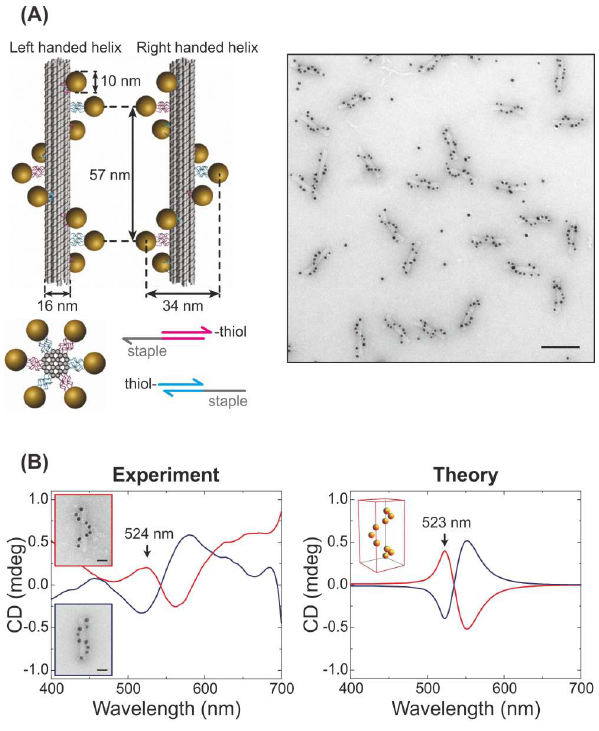
Figure 8: (A) Schematic blueprint of self-assembled gold nano- spheres on DNA bundles arranged as either left-handed or right- handed helix. The panel on the right depicts a transmission electron micrograph of an ensemble of left-handed helices. The scale bar corresponds to 100 nm. (B) Experimental circular dichroism spectra (left) for a left- and right-handed depicted in blue and in red, re- spectively. The corresponding numerical calculations are depicted on the right. (adapted with permission from [54]. Copyright 2012 Nature Publishing